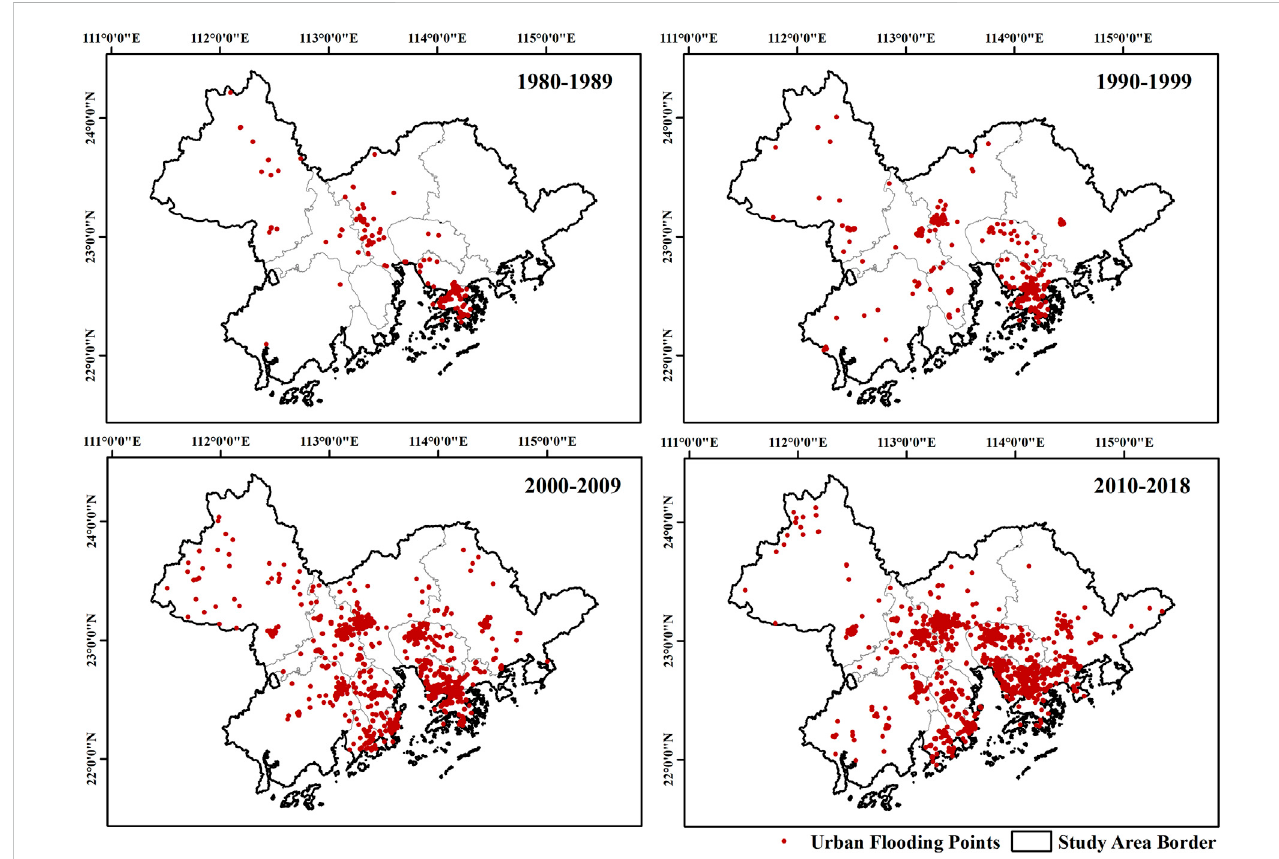
FIGURE 2 Spatial-temporal distribution of urban fl ooding points in the GBA.